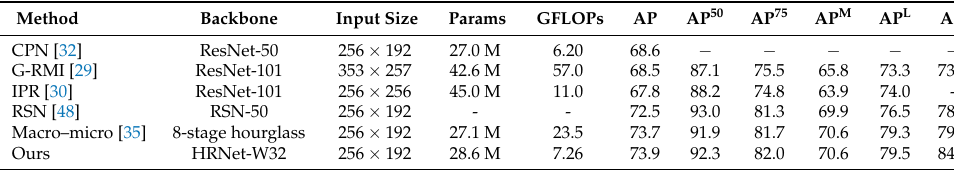
Table 4. Comparisons on the COCO test-dev